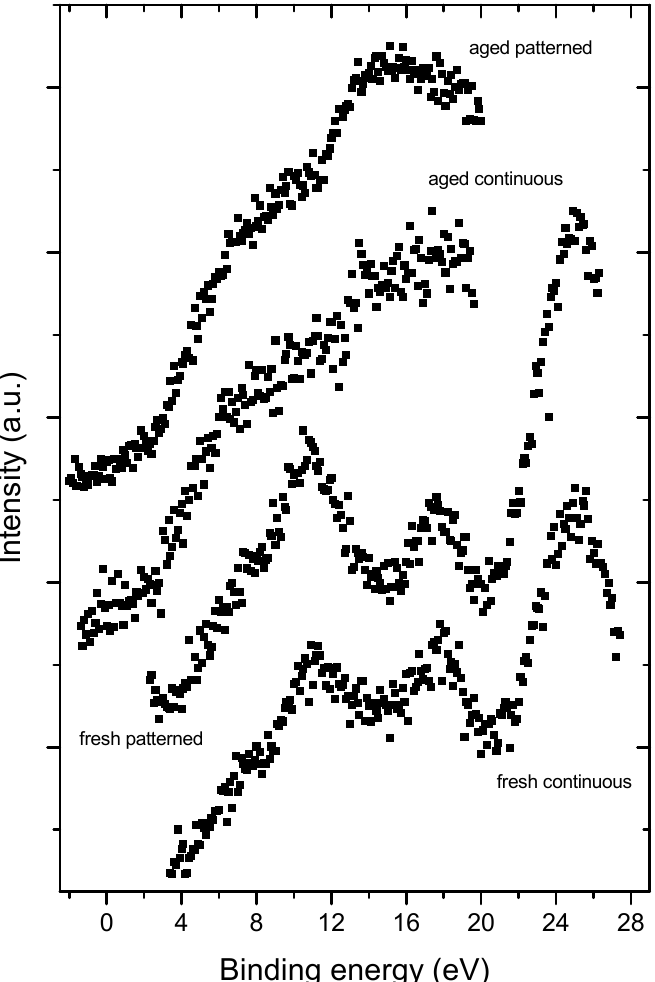
Figure 5. Photoemission from occupied valence bands induced by Mg K α radiation (1253.6 eV). The spectra of fresh prepared samples show oscillations typical for fullerenes. For aged samples, the spectral features are more complex, indicating strong degradation of the fullerene molecular structure or a surface contamination by a carbon-containing species from